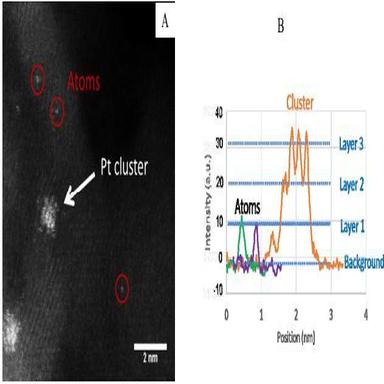
Pt on ɣ-Al2O3 after high temperature reduction 500 °C reduction. AC-STEM image after 500 °C reduction (A). High angle annular dark field (HAADF) intensity of the clusters (B).